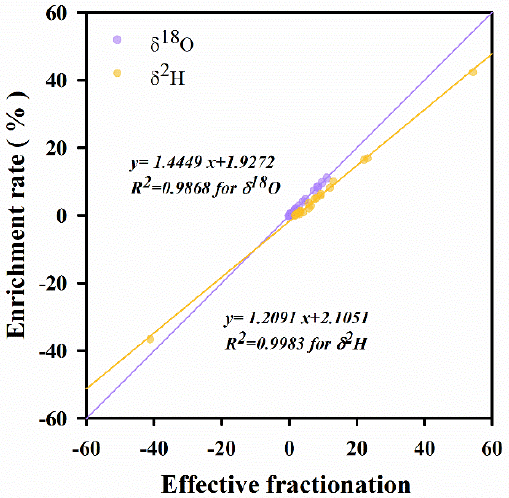
Figure 7. Relationship between the effective fractionation coefficient ( E f ) and enrichment rate of heavy isotopes in precipitation under the cloud base ( E p ).